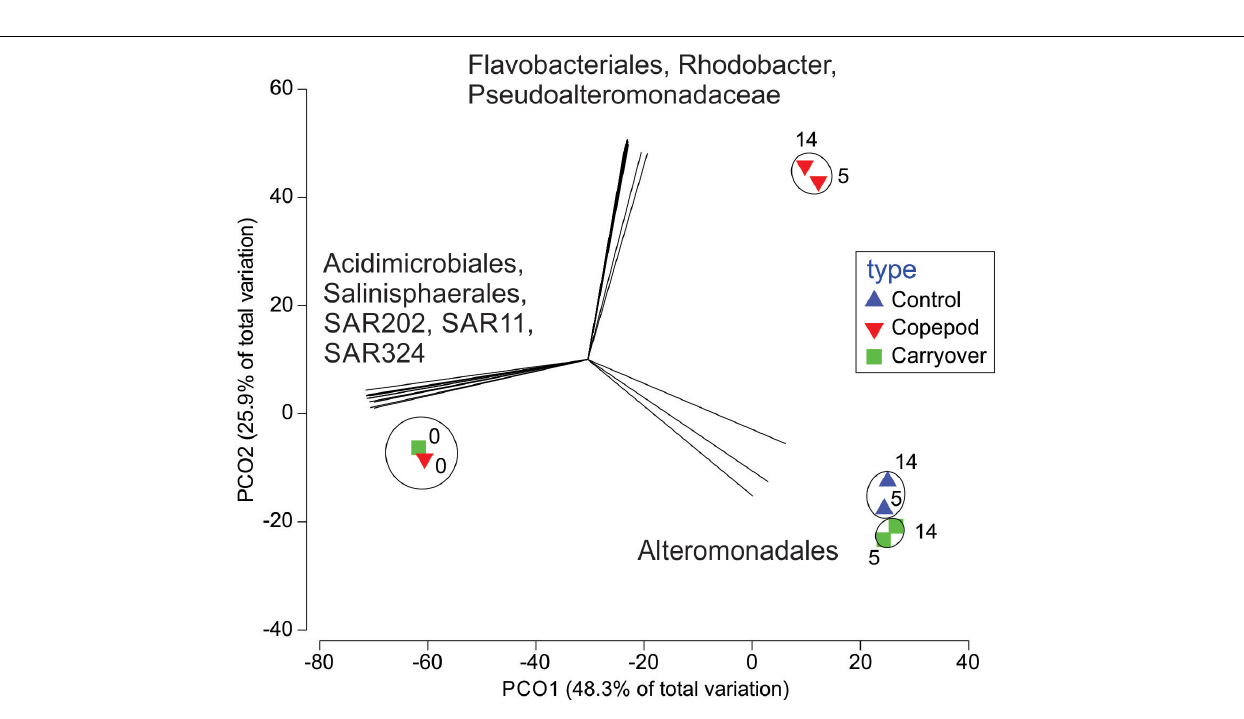
Frontiers in Marine Science |